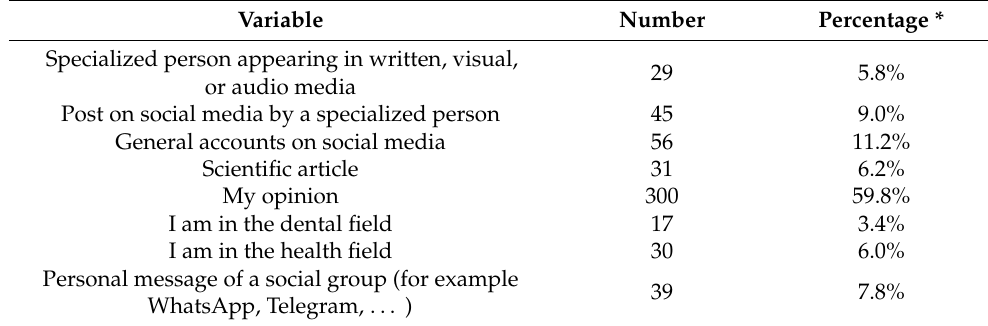
Table 4. Source of information for the association between periodontal disease and systemic